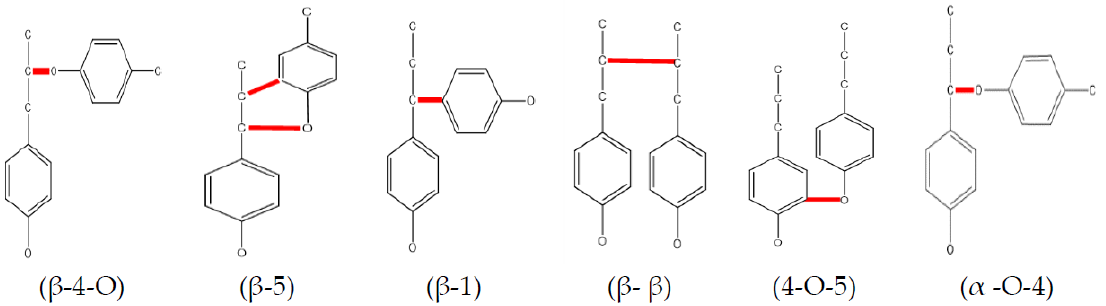
Figure 12. The most important intra-binding across the phenyl propane units (adapted from [89]).